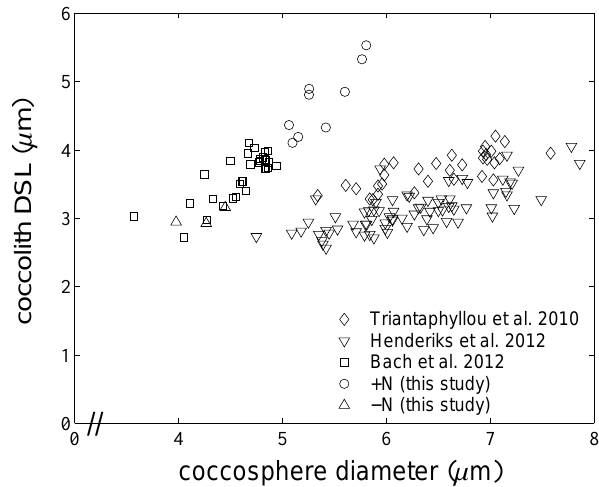
Fig. 6. Emiliania huxleyi coccolith distal shield length (DSL) as a Fig. 6. Emilianiahuxleyi coccolith distal shield length (DSL) as a function of coccosphere diameter function of coccosphere diameter from field and laboratory stud- ies. Field data are from Mediterranean waters ( E. huxleyi domi- from field and laboratory studies. Field data are from Mediterranean waters ( E. huxleyi dominated nated samples, Triantaphylloua et al., 2010) and from the chloro- samples, Triantaphylloua et al. (2010)) and from the chlorophyll maximum near the cost of Namibia phyll maximum near the cost of Namibia (Henderiks et al., 2012). (Henderiks et al., 2012). Laboratory data are from a carbonate chemistry manipulation experiment Laboratory data are from a carbonate chemistry manipulation exper- (Bach et al., 2012) and this study. Details about measurement procedure and inherent errors can iment (Bach et al., 2012) and this study. Details about measurement be found in the original studies. procedure and inherent errors can be found in the original